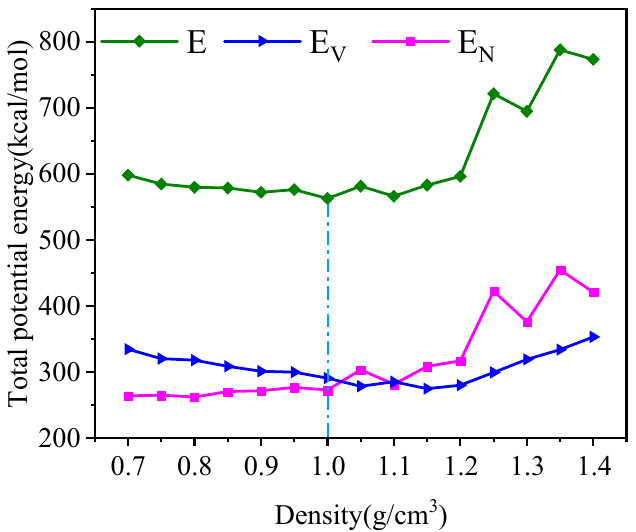
Figure 8. Structure of gas coal with a density of 1.0 g/cm 3 .